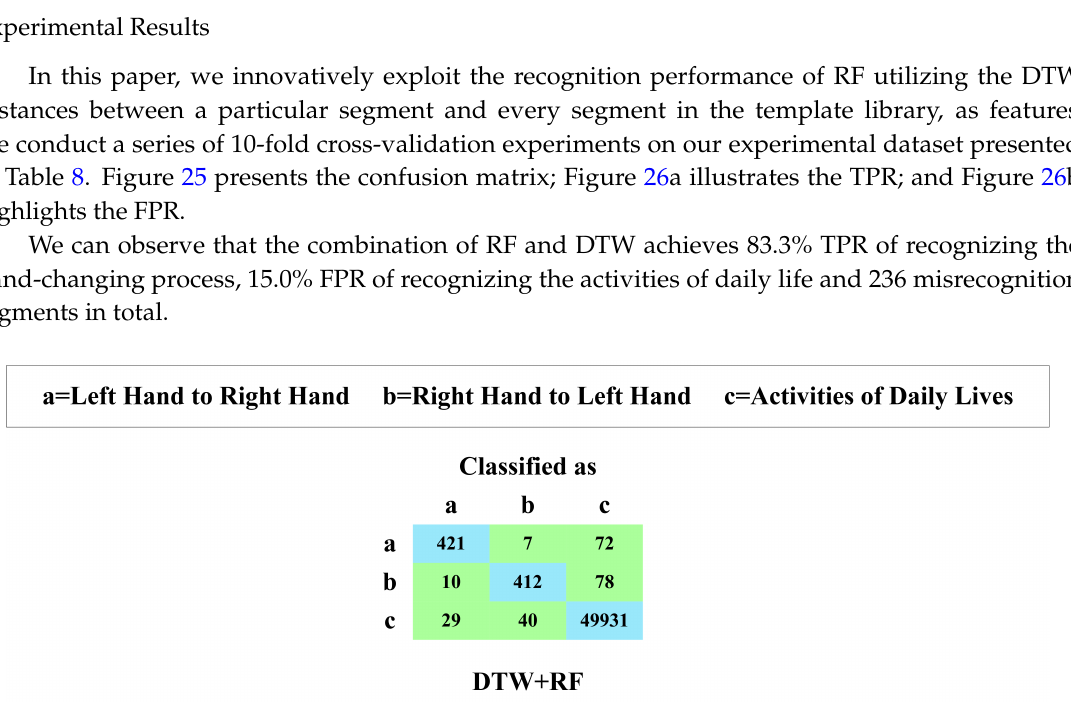
Figure 25. Confusion matrix of RF along with